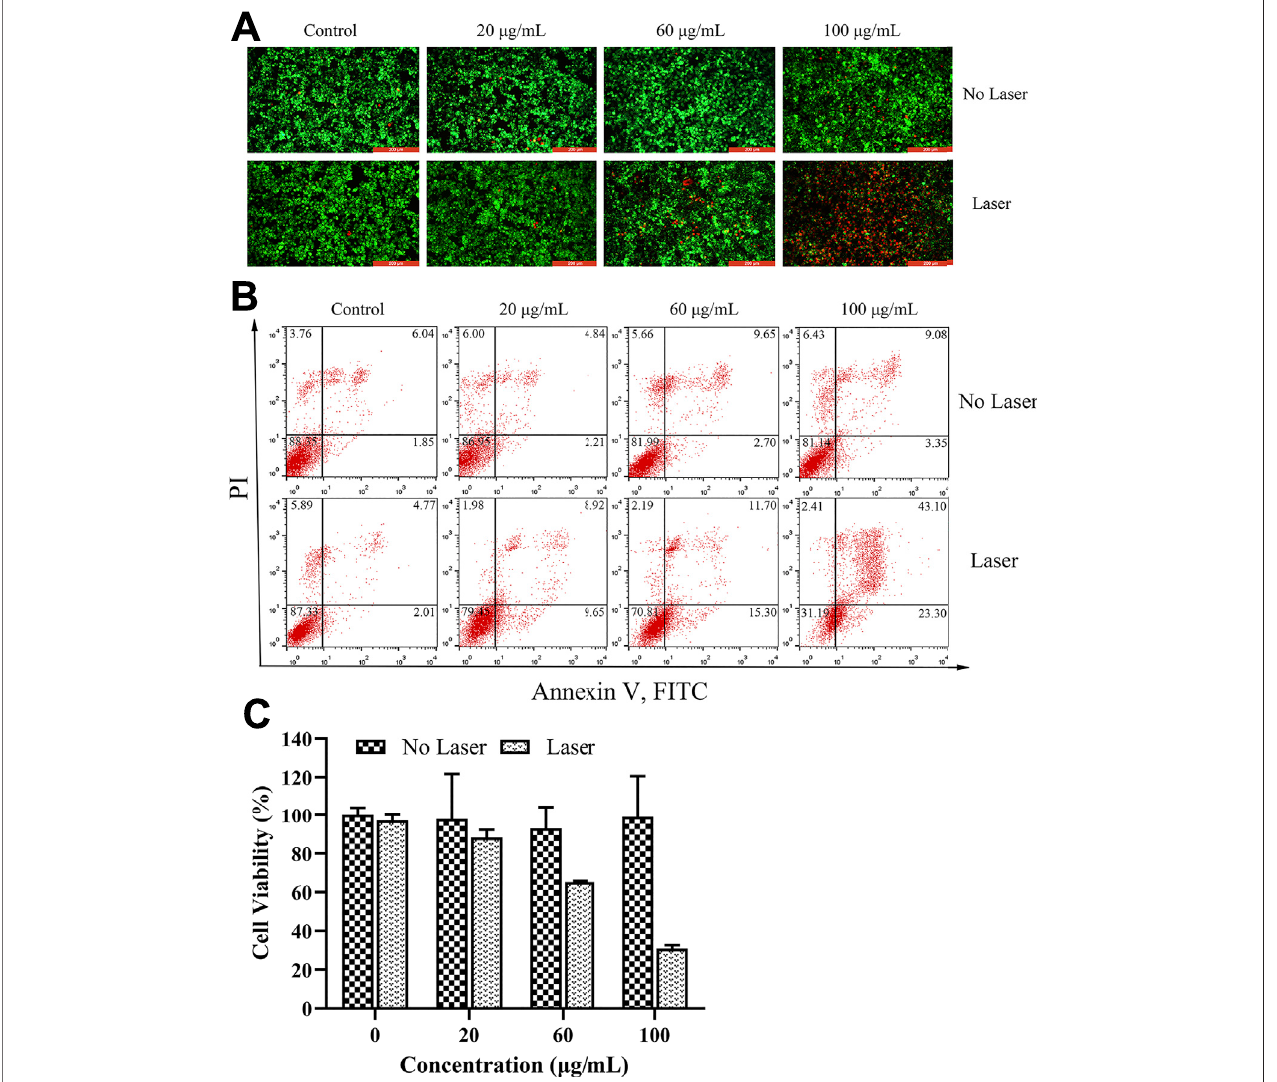
FIGURE 5 | (A) Fluorescence images of 4T1 cells upon NIR irradiation (0 and 5 min) with different concentrations of PDA@MB (0, 20, 60, and 100 μ g/ml). Green: Calcein-AM, live cells; Red: PI, dead cells; The scale bar is 200 μ m. (B) Flow cytometric analysis of 4T1 cell apoptosis after treatment with PDA@MB. (C) Cell viability